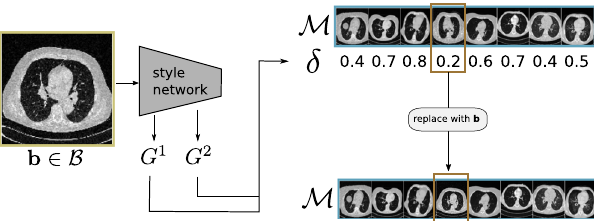
Fig. 7 Updating dynamic memory M of size 8 with a new sample b, taken from the input-mini-batch. (1) The image is given to the style model and the Gram matrices G 1 , G 2 are calculated. (2) Based on those matrices the Gram distance δ between b and each element in the memory is calculated. (3) b replaces the memory element with minimal distance δ